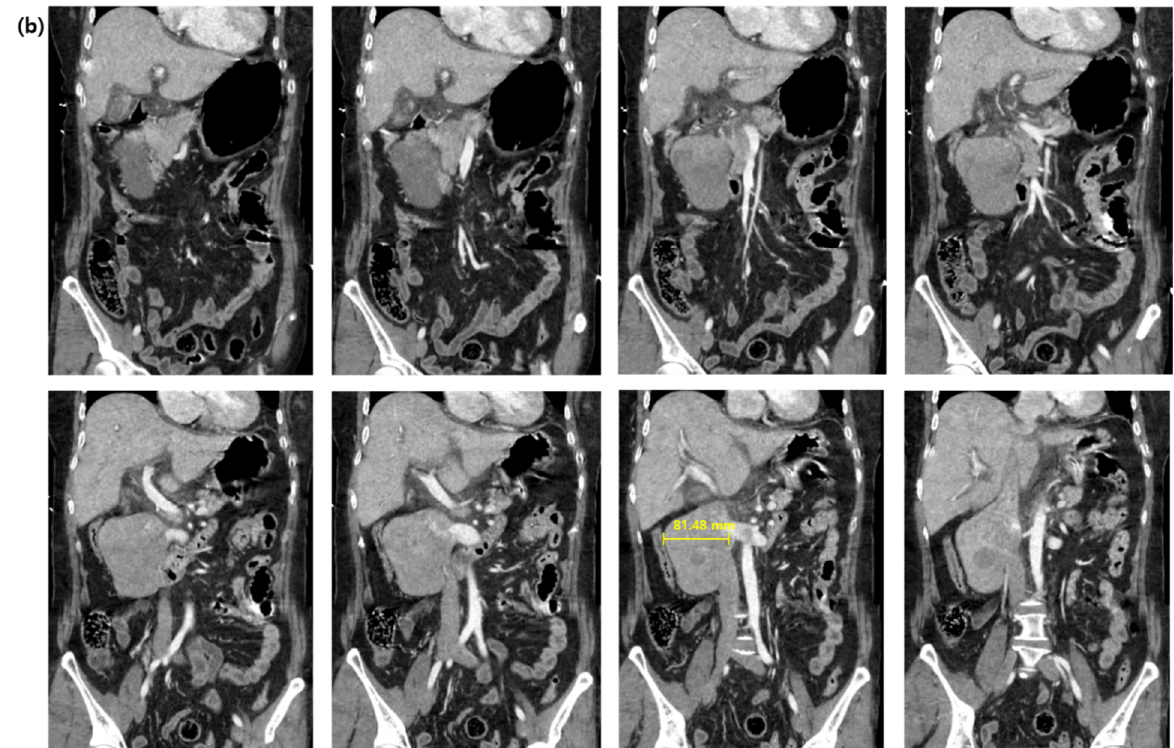
Figure 1. Computed tomography images of the abdomen and pelvis in ( a ) the axial and sagittal planes, and ( b ) the coronal plane. Arrows indicate an inferior vena cava aneurysm.